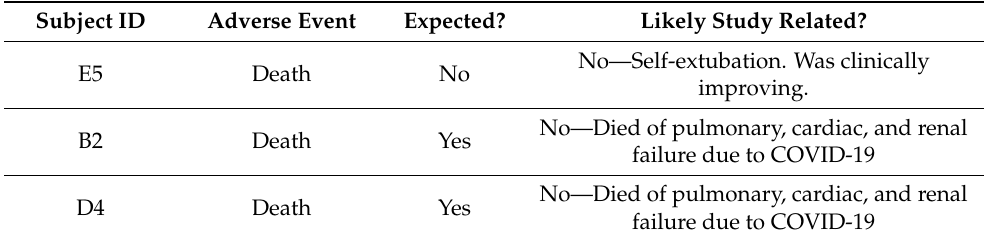
Table 8. Adverse Event by